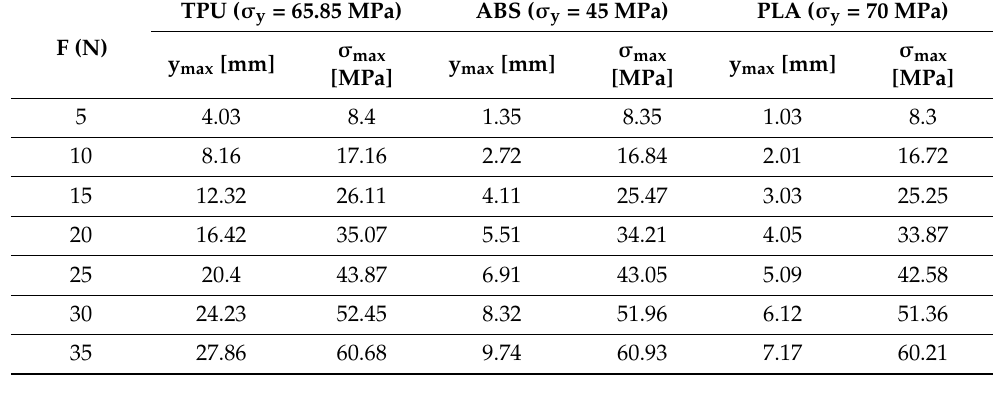
Figure 4. Comparison of resulted displacement and degree deformation at the same applied force-35 N for all investigated materials. Table 3. Obtained results for Von Mises stress and displacement between gripping elements.